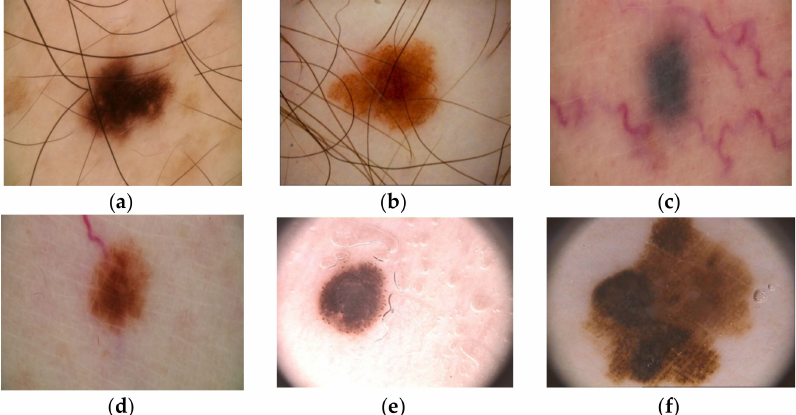
Figure 1. Artifacts in Me images collected from the ISIC 2016 dataset [14]: ( a – c )—presence of hair, ( d )—presence of blood vessels, ( e , f )—presence of oil drops.